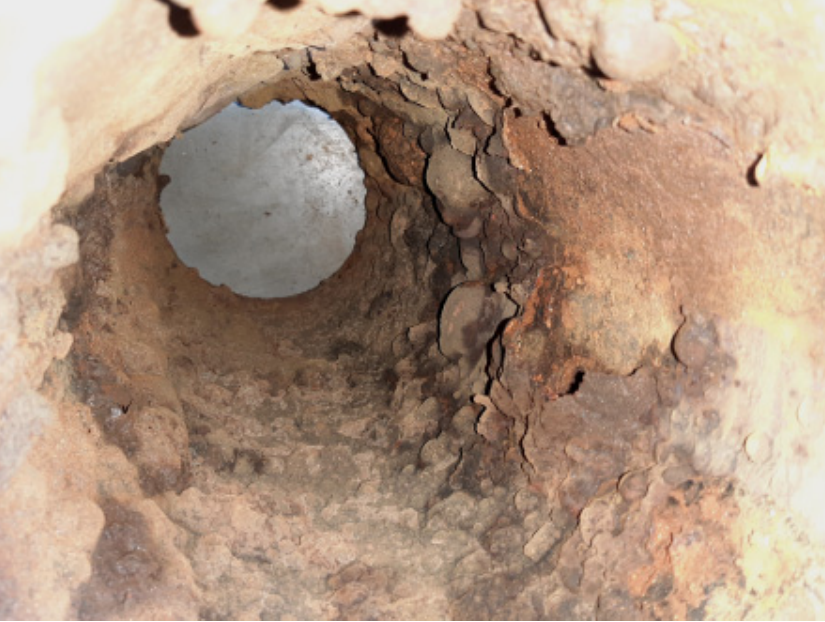
Figure 1. Drinking water pipe (normal diameter 200) gray cast iron pipe as habitat for invertebrates, typical are incrustations and biofilm coating.